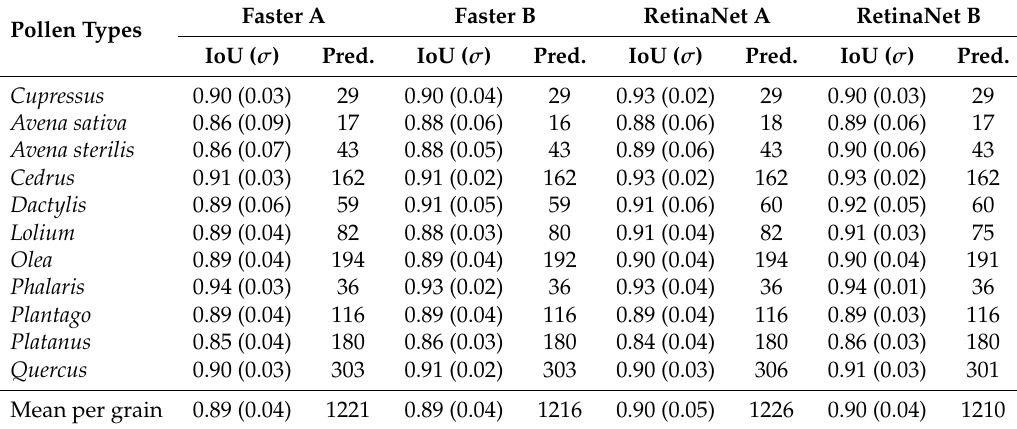
Table 7. Accuracy in the location of pollen grains for the classes studied, expressed in terms of IoU between the predictions with the ground-truth bounding boxes of real grains. The standard deviation is indicated in